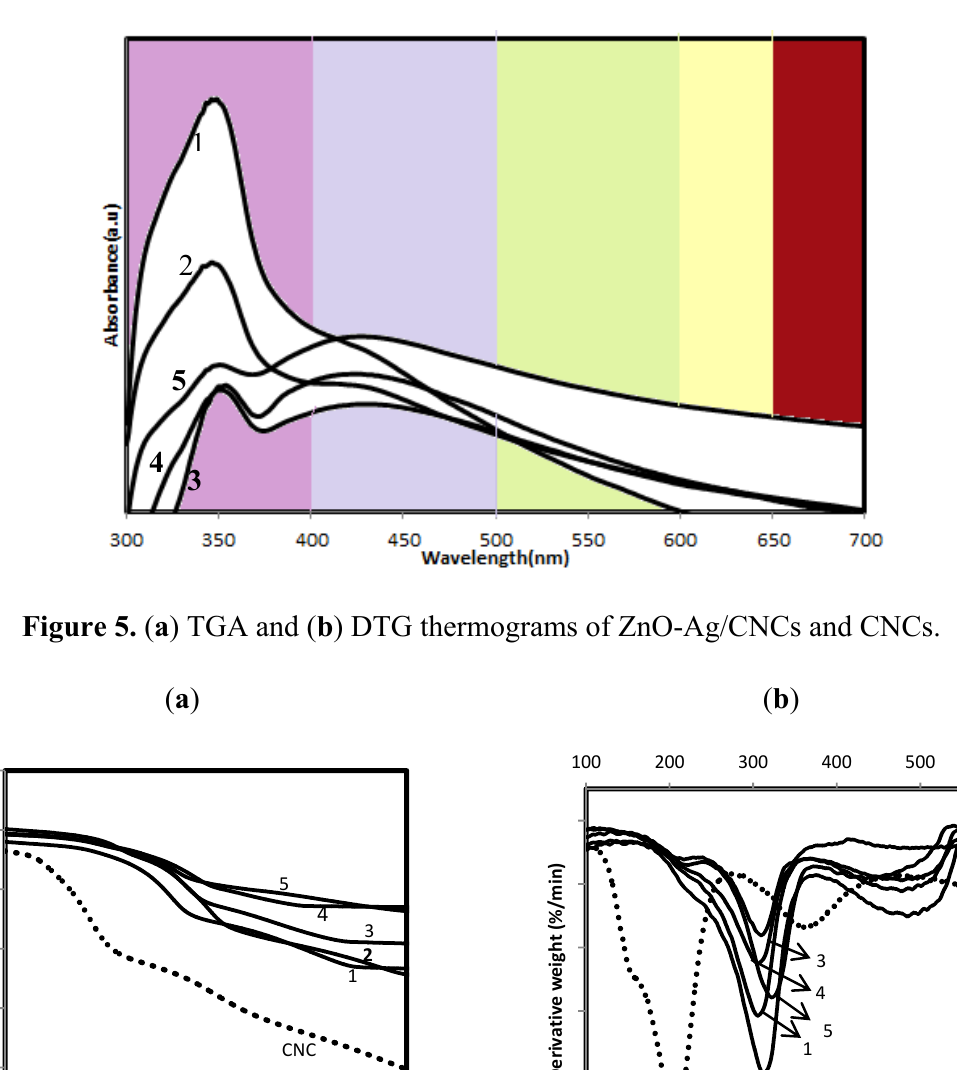
Figure 4. UV-vis absorbance spectra of ZnO-Ag/CNCs samples.